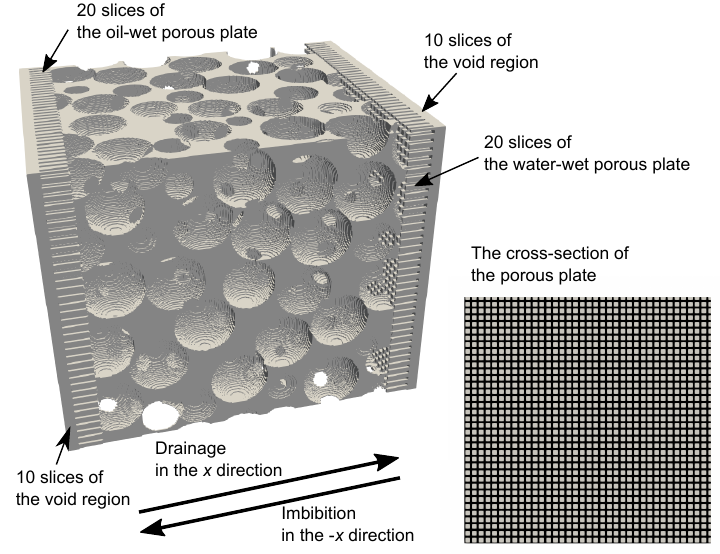
Figure 11. The simulation model used for the study. ( Left ) the pore structure of the bead pack. Here, pore space is shown in white, while solid is transparent. ( Right ) the cross-section of the porous plate attached to the porous domain. Here, pore space is shown in white, while solid is black. This porous plate consisted of the mesh of square pores 5 voxels in width and 20 voxels in length with a contact angle of 150 ◦ for the oil-wet porous plate and 30 ◦ for the water-wet porous